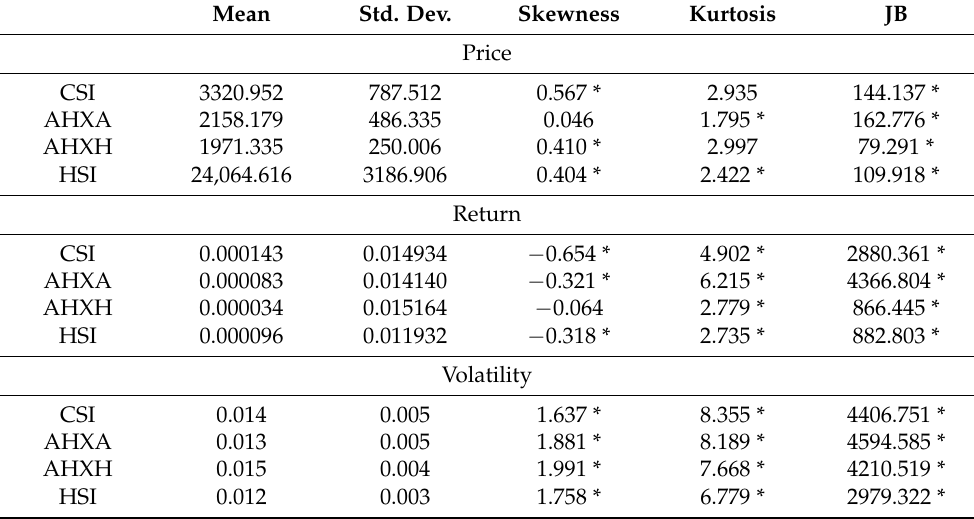
Table 2. Descriptive statistics.